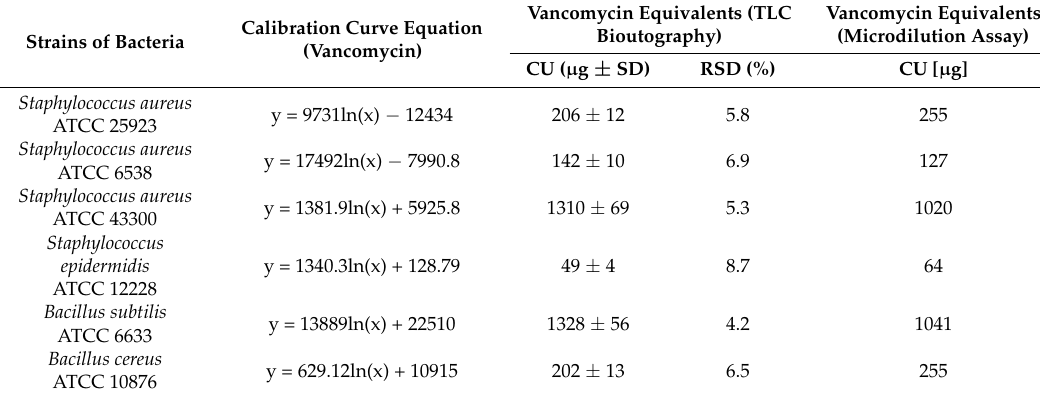
Table 4. Determination of vancomycin equivalents for curcumin determined in the bioautographic and microdilution